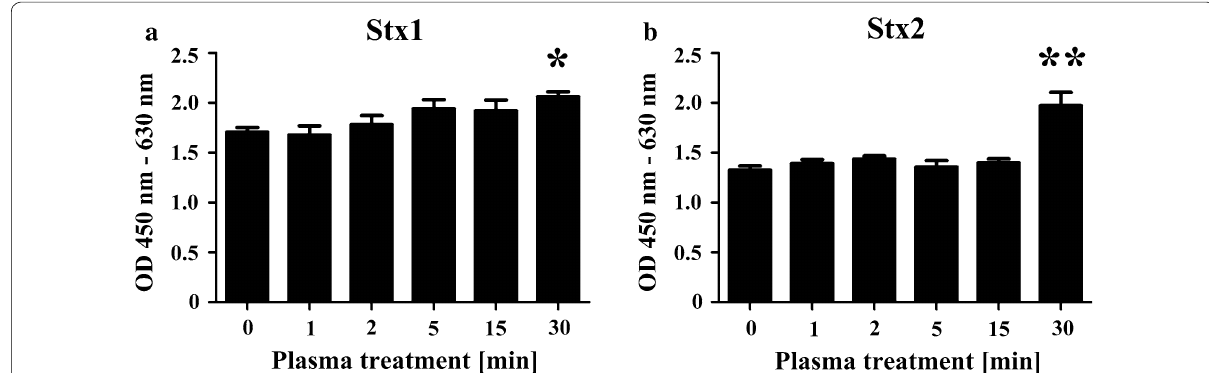
Fig. 4 Decreasing cell toxicity of Stx1 and Stx2 after nitrogen gas plasma treatment. A coverslip containing dried spots from 20 μl aliquots of a 1 μg/ml solution of Stx1 ( a ) and Stx2 ( b ) was treated with nitrogen gas plasma using BLP-TES device (1.5 kpps) for 0, 1, 2, 5, 15, and 30 min. The recovered samples were diluted 50-fold with minimum essential medium (MEM) and then added to HEp-2 cells at 100 μl/well in a microtiter plate. After incubation at 37 °C for 24 h for Stx1 and for 48 h for Stx2, the viability of HEp-2 cells was monitored using a Cell counting kit 8 (Dojindo, Kuma- moto, Japan). The activity of Stx, which was measured on the basis of cell toxicity of Stx to HEp-2 cells, was significantly inhibited, as compared with no treatment (0 min), by 30 min of nitrogen gas plasma treatment using BLP-TES (* p < 0.05, ** p <